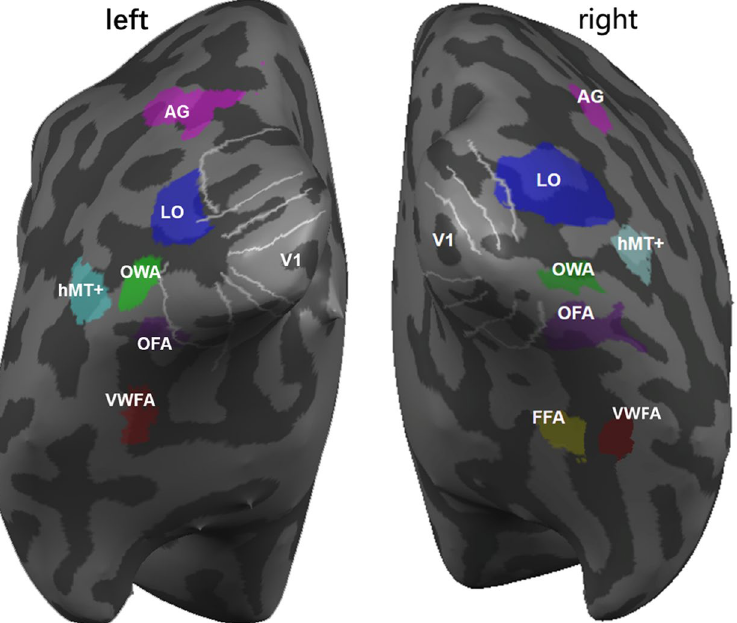
Figure 1. Relative spatial position of ROIs in a typical subject’s inflated brain. OWA is mainly located near inferior or middle occipital gyrus, posterior to VWFA, inferior to hMT + , more ventral to LO and anterior to the retinotopic areas. The white lines indicate the boundaries of the retinotopic areas. LO: lateral occipital complex (also named as LOC in other parts of the paper). AG: angular gyrus. hMT + :human motion-selective complex. OWA: occipital word sensitive area. OFA: occipital face area. VWFA: visual word form area. FFA: fusiform face area. V1: primary visual